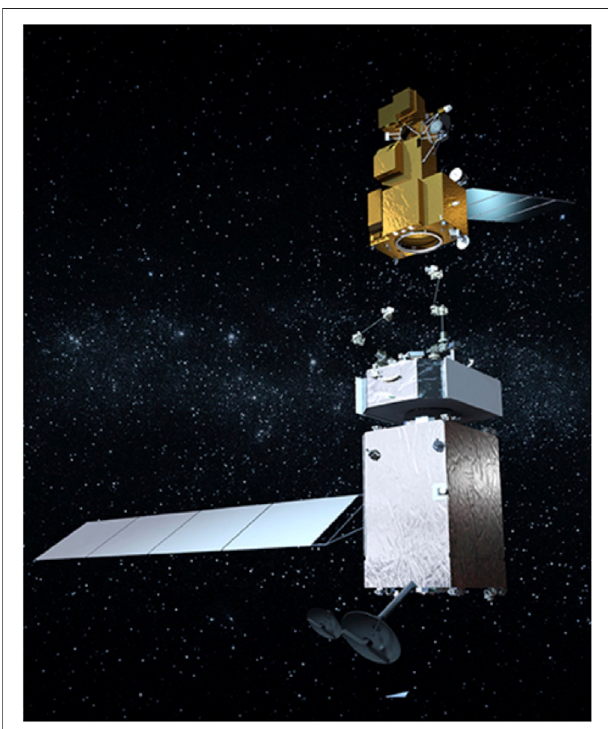
FIGURE 9 | NASA/SSL OSAM-1 mission (NASA/GSFC,